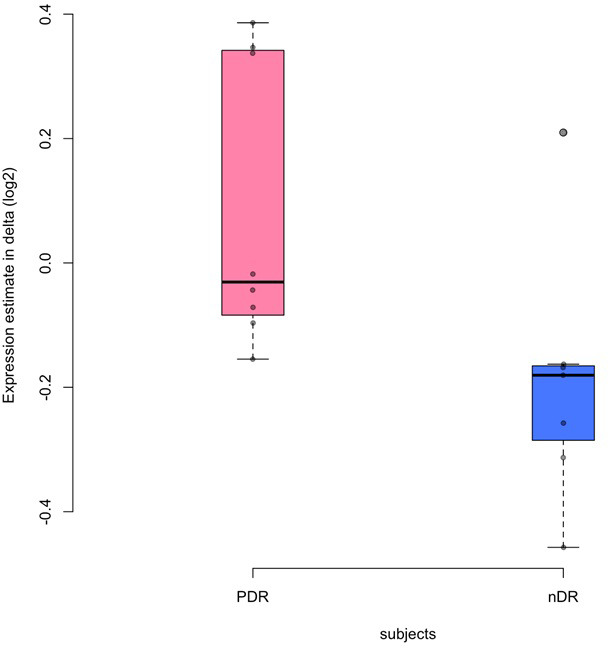
Folliculin (FLCN) expression response to glucose by disease status (PDR vs. nDR).Box and whisker plot of the change in FLCN expression in lymphoblastoid cell lines between standard glucose and high glucose conditions. Pink indicates the distribution of responses for individuals with proliferative diabetic retinopathy (PDR) (log2FC = 0.08), and blue indicates the same for individuals with diabetes but no retinopathy (nDR) (log2FC = −0.19). Y-axis measures the difference in expression fold change on the log2 scale. Each individual is represented by a dot. Difference in means between PDR and nDR is 0.27, p-value 0.003. Source and code files for this plot are available in Gene Expression Omnibus (GEO) at https://www.ncbi.nlm.nih.gov/geo/ under accession code GSE146615, and Source code 13.